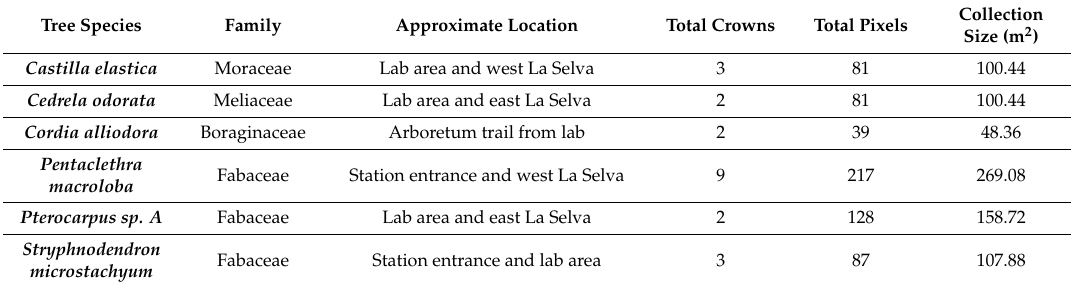
Table 3. Six tree species extracted for ground truth in May 2017 from various locations within La Selva Biological Station, Costa Rica.